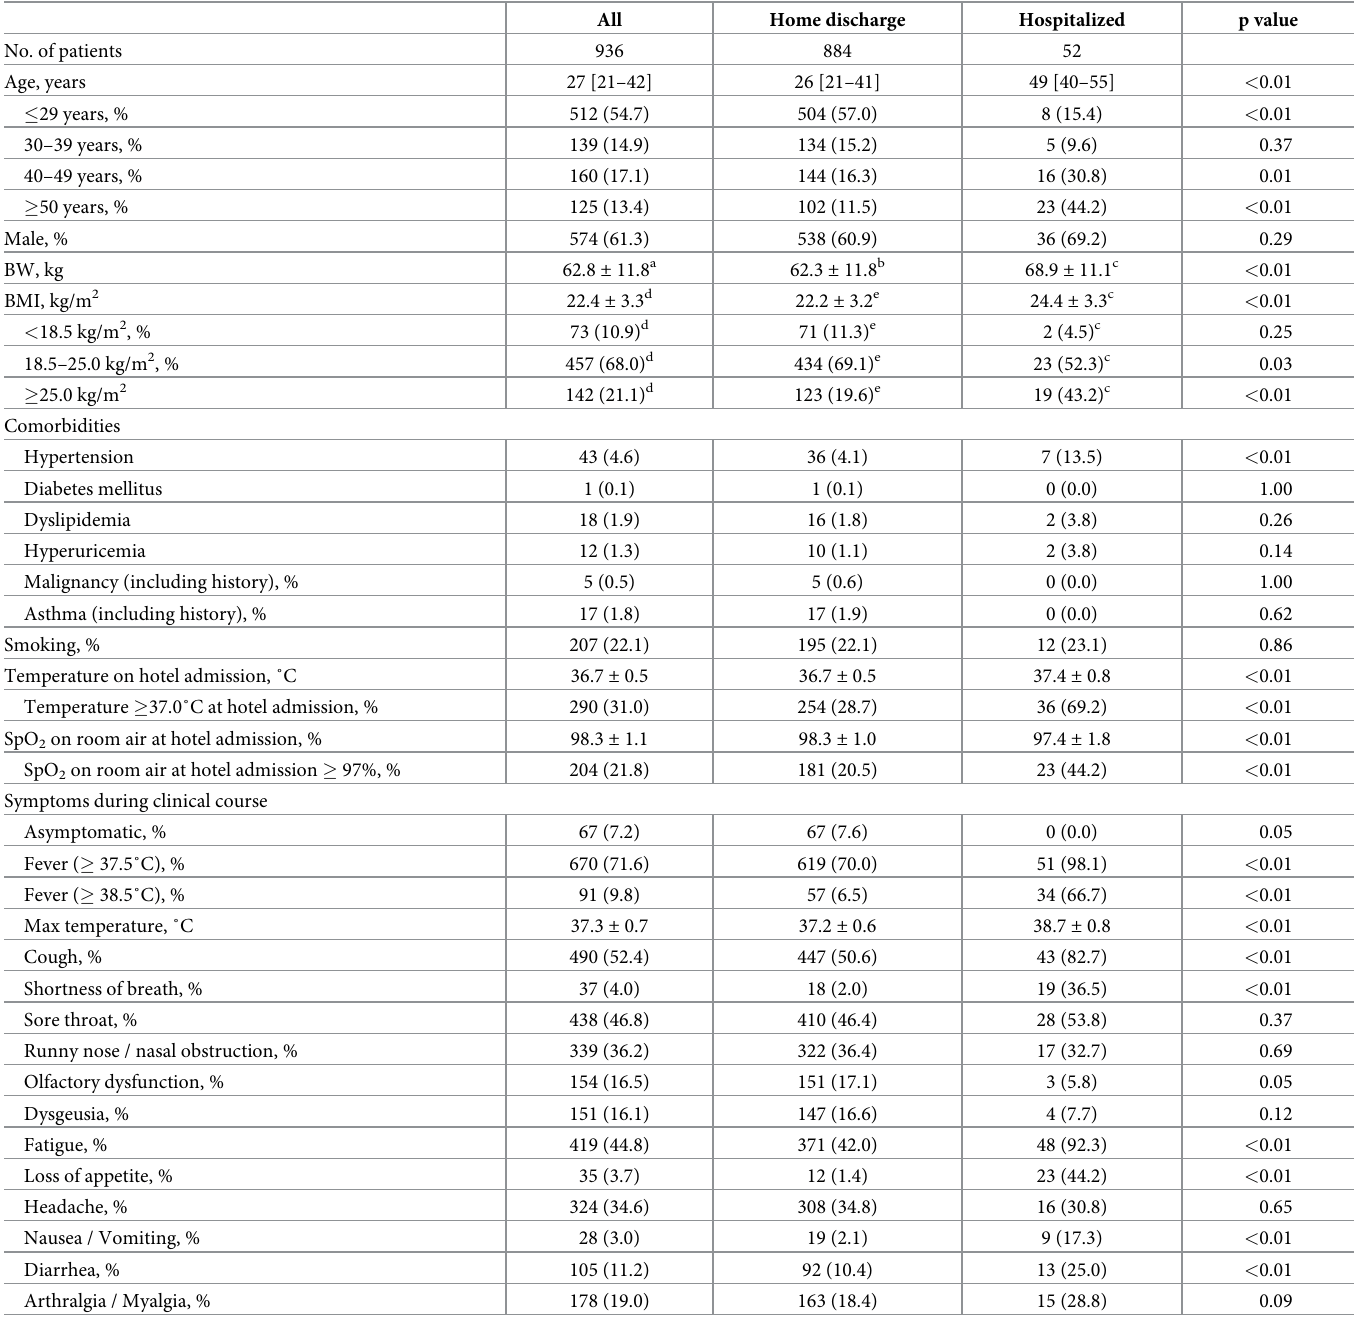
Table 1. Patients’ characteristics and